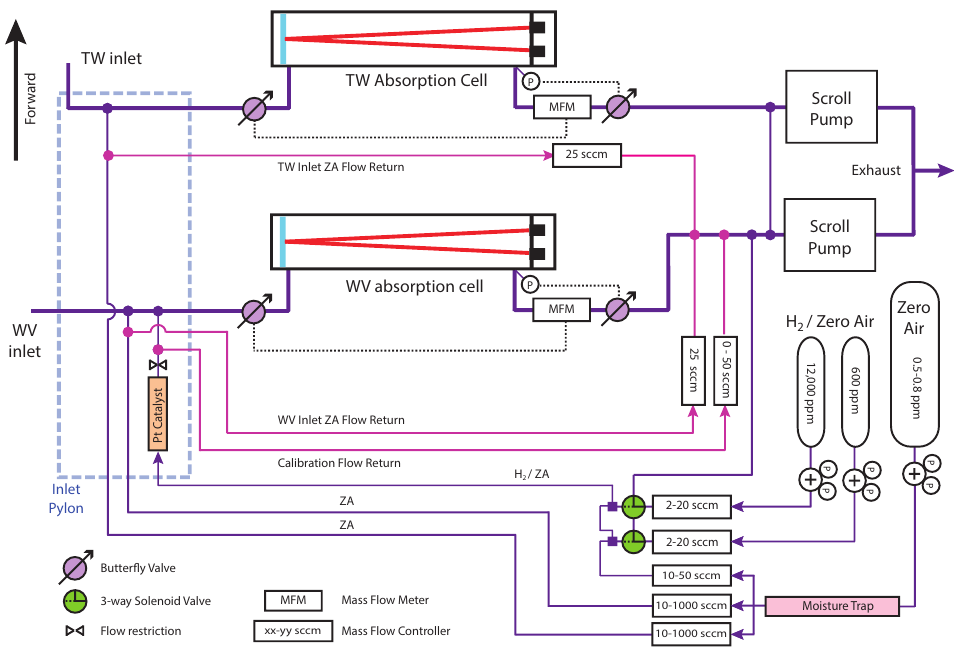
Figure 2. Schematic of the NOAA Water instrument showing the components of the dual-channel flow system. The custom butterfly valves located upstream and downstream of each cell are used to control the mass flow (upstream) and pressure (downstream) in the optical cells to constant values independent of variations in sampling pressure as the aircraft changes altitude. The numbers in the mass flow controller symbols indicate the flow value or range used during flight operation.